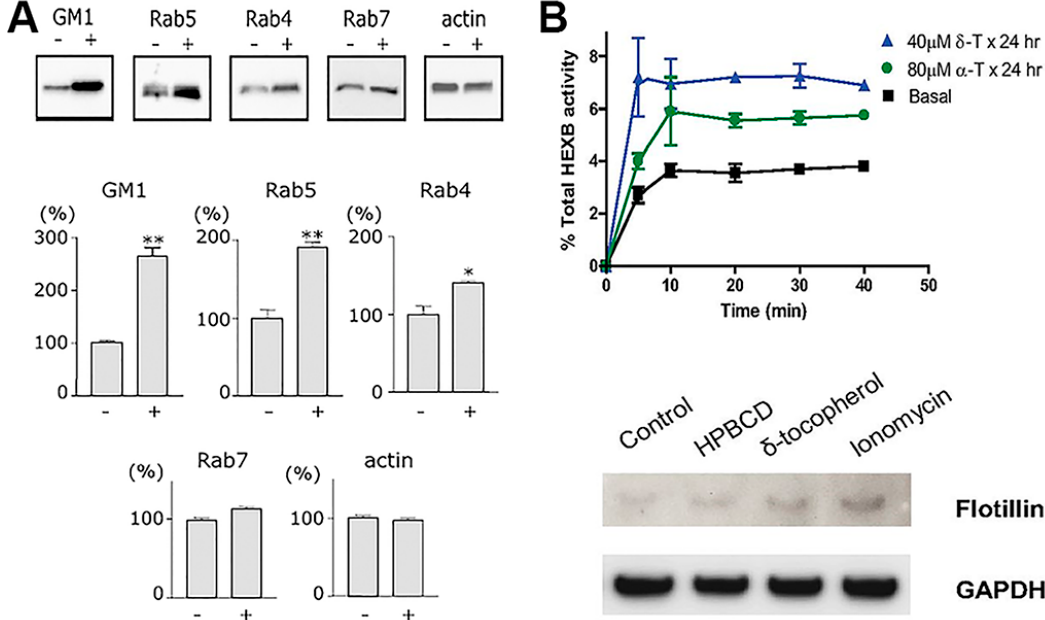
Figure 4. Endocytic alterations caused by therapeutic drugs. ( A ) Western blot protein bands (upper panels) and densitometry (bottom panels) showing the effect of the antimalarial and cancer treatment drug, chloroquine, on the level of vesicular transport elements in PC12 cells activated for endocytosis with cholera toxin B. ( B ) The upper graph shows lysosomal exocytosis, measured as extracellular release of lysosomal enzyme HEXB, in fibroblasts from normal individuals treated with by δ - or α -tocopherol. The bottom panel shows Western blot analysis of flotillin-2 in exosomal fraction of cell treated with hydroxypropyl- β -cyclodextrin (a positive control), δ -tocopherol, or ionomycin, normalized by glyceraldehyde 3-phosphate dehydrogenase (GAPDH) levels. Data are mean ± SEM, ** p < 0.05, Student’s t test. Adapted and reproduced with permission from: ( A ) Figure 2 in [139]. Copyright 2006 Federation of European Biochemical Societies; ( B ) Figure 4 in [140]. Copyright 2012 The American Society for Biochemistry and Molecular Biology, Inc.